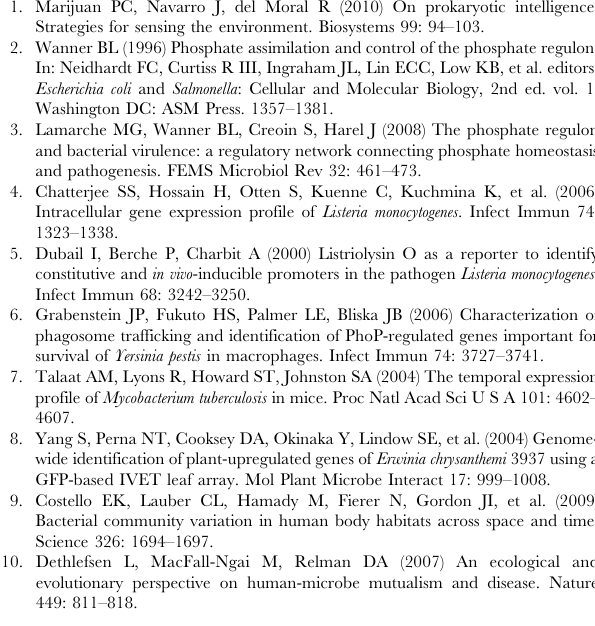
Table S3 The wid-type genes whose expressions were induced . 4-fold by Pi starvation. Table S4 The wid-type genes whose expressions were repressed . 4-fold by Pi starvation. Table S5 The phoB mutant genes whose expressions were induced . 4-fold by Pi starvation. Table S6 The phoB mutant genes whose expressions were repressed . 4-fold by Pi